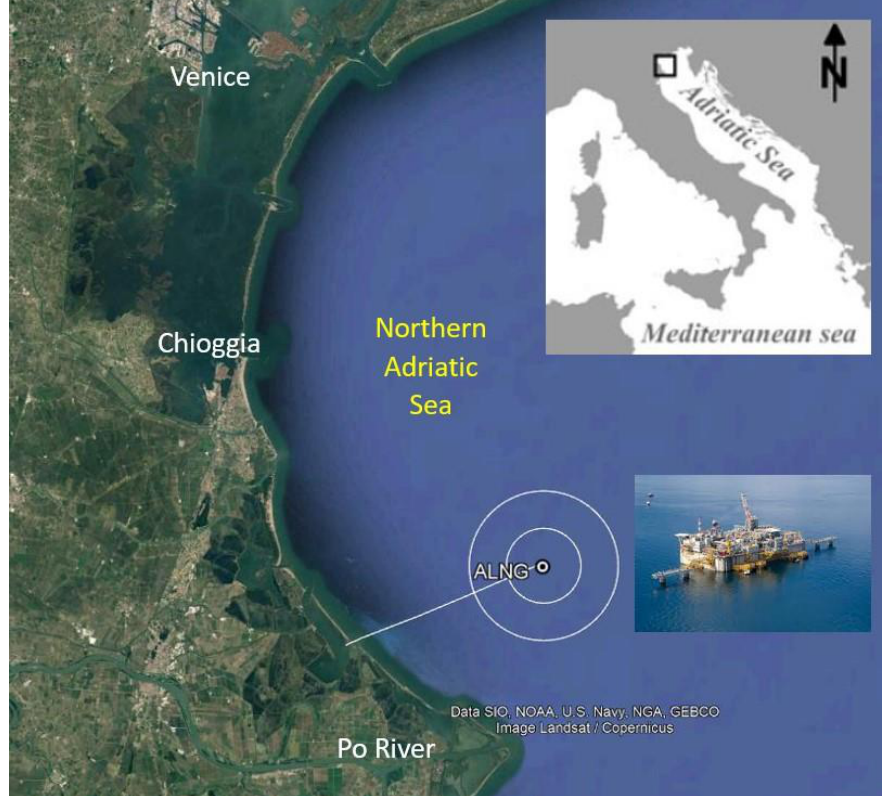
Figure 1. Study area and location of LNG terminal (ALNG) in the Northern Adriatic Sea. The terminal (see small photo) is enclosed by a “no entry zone” (1.5 nautical miles (nm) radius) and a “respect zone” (3 nm radius). The gas pipeline, connecting the ALNG to land, is also shown.